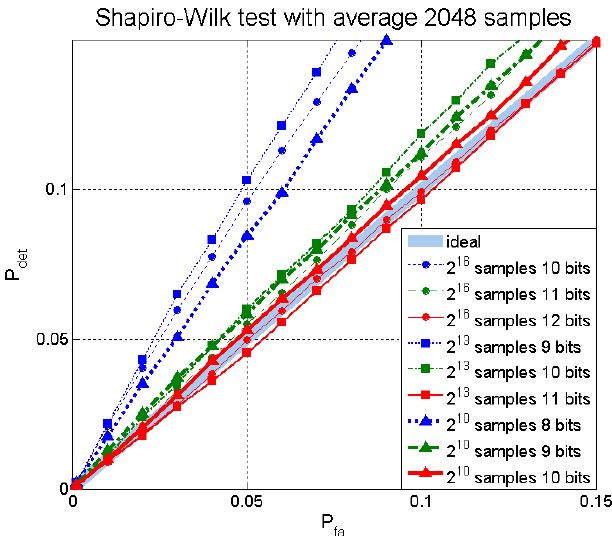
Figure 2. Shapiro-Wilk validity test as a function of the sample length and the quantization level. Dotted and dash-dotted lines represent invalid test cases (error >5%), solid lines represent cases where the test is valid (error <5%). Lower number of bits in lines of the same color (same sample size) lead to sample sets “detected” as